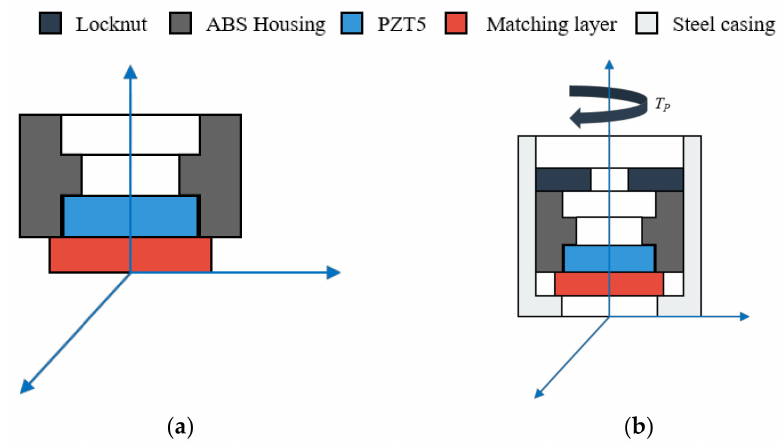
Figure3. Schematicdiagramof( a )typicalair-coupledtransducer; ( b )prestressedair-coupledtransducer.